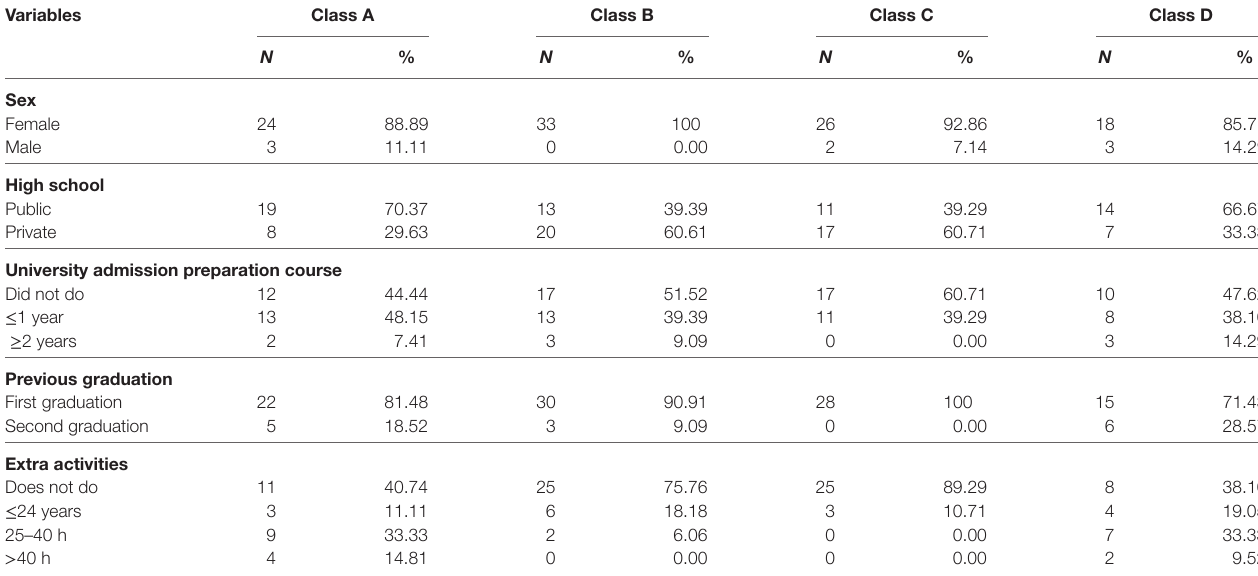
TaBle 1 | Demographic data of the four classes.